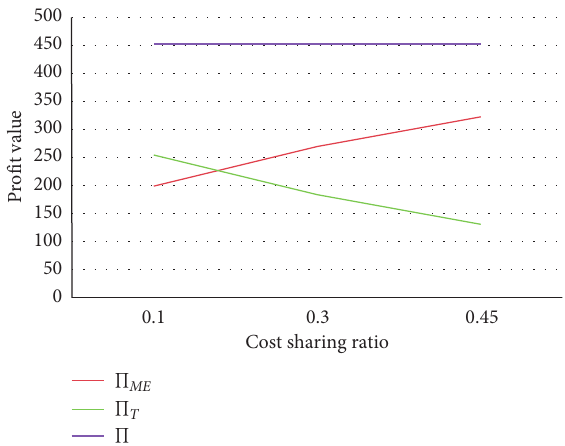
Figure 5: Sensitivity of cost sharing in semicentralized model